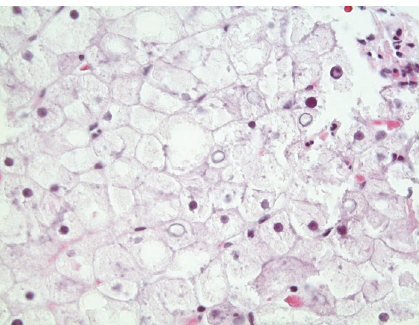
Figure 1: Liver biopsy specimen. Portal triad in center. Hepatocytes have pale faintly granular eosinophilic to clear cytoplasm. Note that some nuclei have cleared chromatin (nuclear glycogenosis), which can be seen in various metabolic conditions, such as diabetes mellitus (Hematoxylin and Eosin staining at 400x